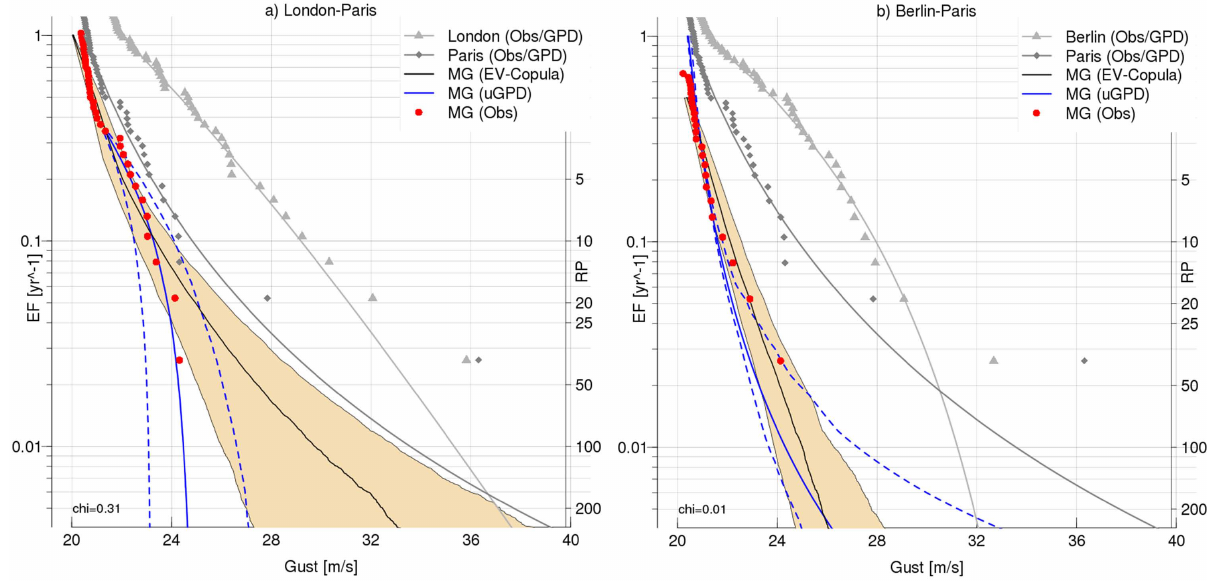
Fig. 7. Calibration targets for London-Paris (a) and Berlin-Paris (b) . Gray lines and dots show marginal gust Exceedance Frequencies (EF [yr − 1 ] ) and observed gust values at each location separately. Red dots show observed M(inumum) G(usts) exceeded at the two locations during the passage of a single storm. Solid blue lines depict targets as derived from univariate GPD fiting on observed MGs (dashed blue lines represent 95% confidence level), while black solid lines show EV-Copula targets (95% confidence level is shown in yellow). Note that EV-Copula and univariate GPD targets differ for London-Paris and are in much closer agreement for